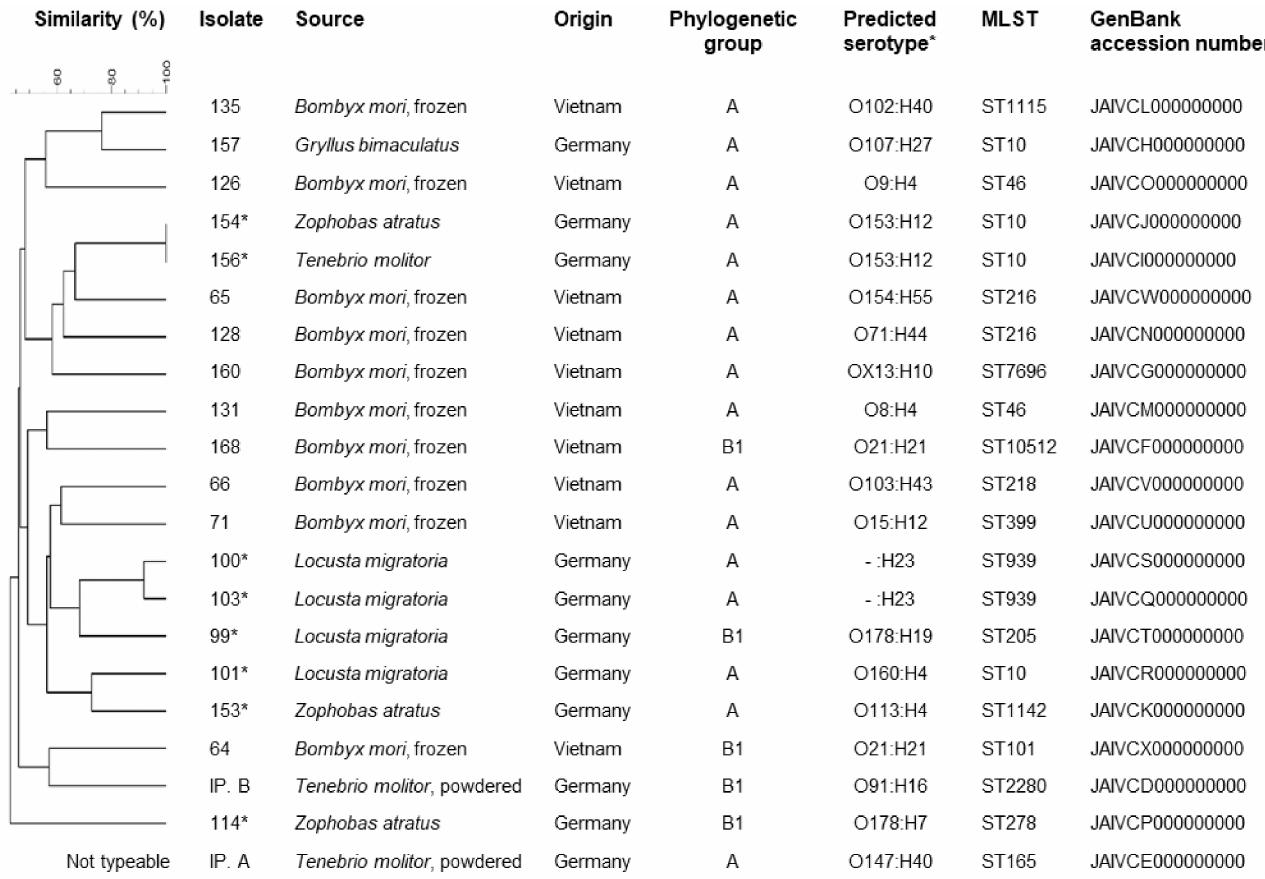
Figure 1. Origin and molecular typing results of the 21 E. coli isolates. Accession numbers refer to genome sequences deposited in the GenBank database. * Isolates recovered from samples purchased at pet feed